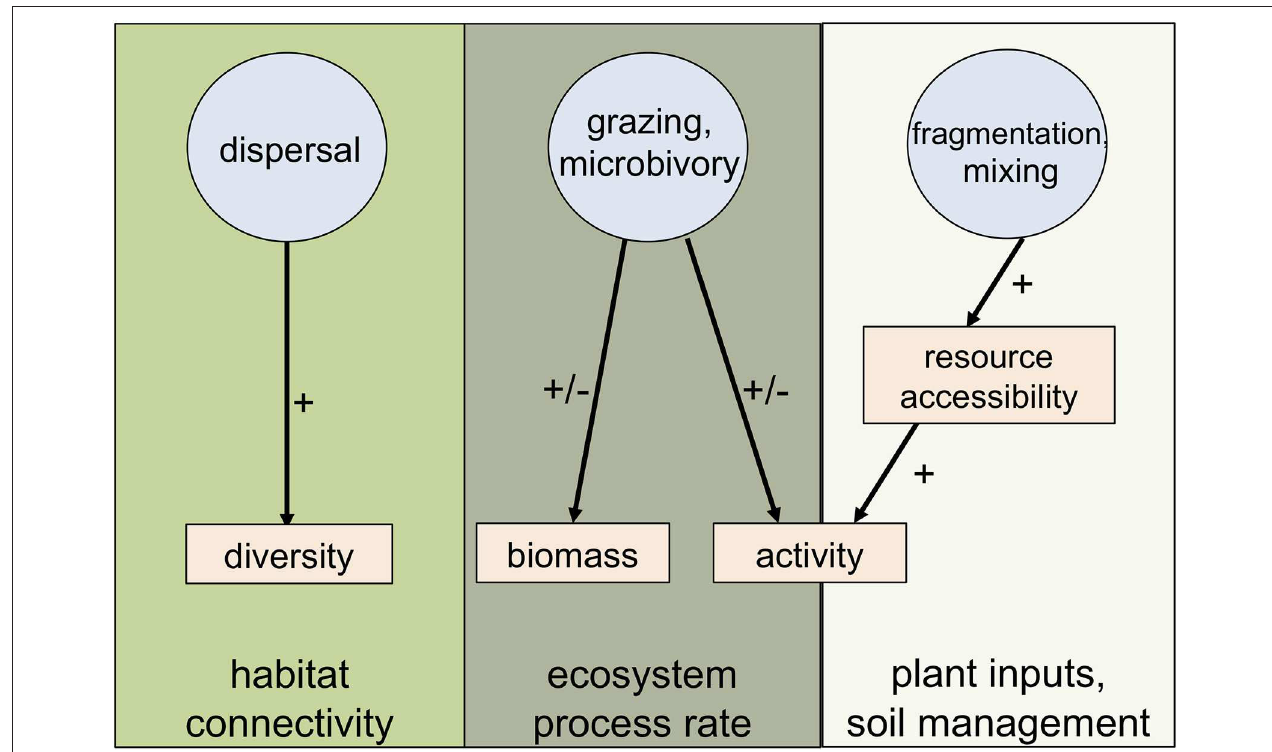
FIGURE 1 | Three proposed invertebrate pathways that alter microbial communities in urban soils; invertebrates either have positive ( + ) and/or negative ( − ) effects on the different microbial response metrics and interactions between the different invertebrate pathways and the microbial metric affect distinct soil